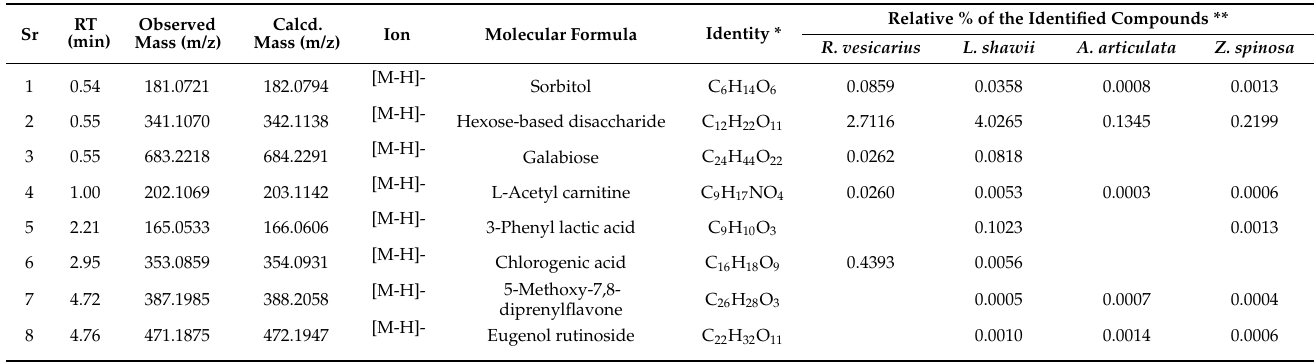
Table 2. LC-MS result analyses of the four